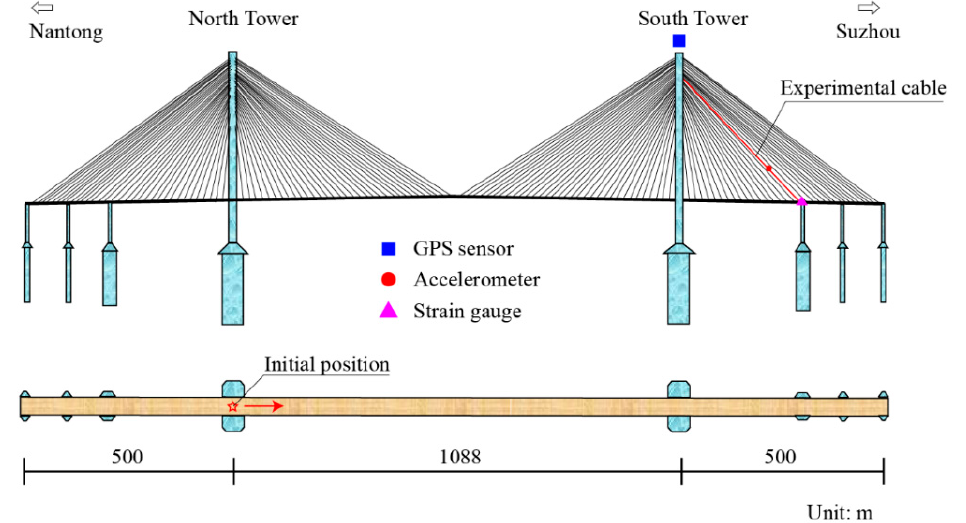
Figure 12. Basic information on the experimental bridge and sensors.